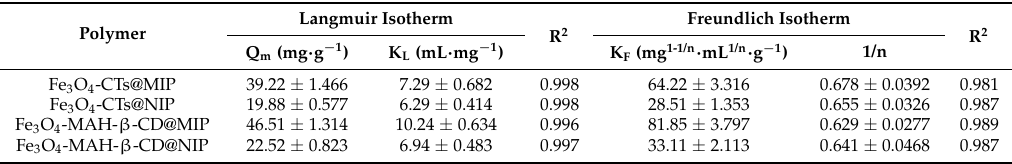
Table 1. Adsorption isotherm parameters for 2-aminopyridine on Fe 3 O 4 -CTs@MIP, Fe 3 O 4